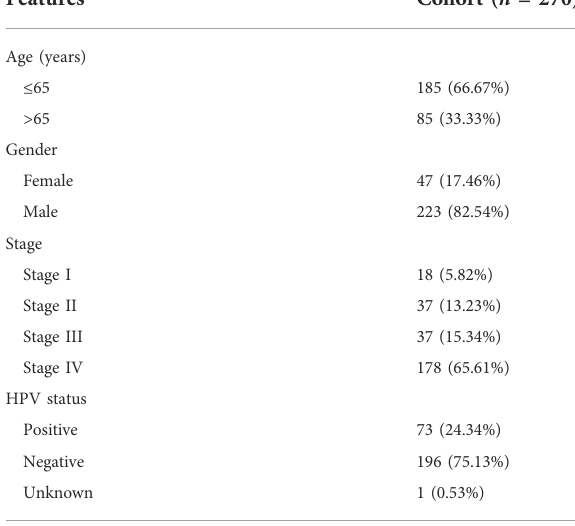
TABLE 3 Clinicopathological characteristics of HNSC patients in the cohort of GSE65858 in GEO database.